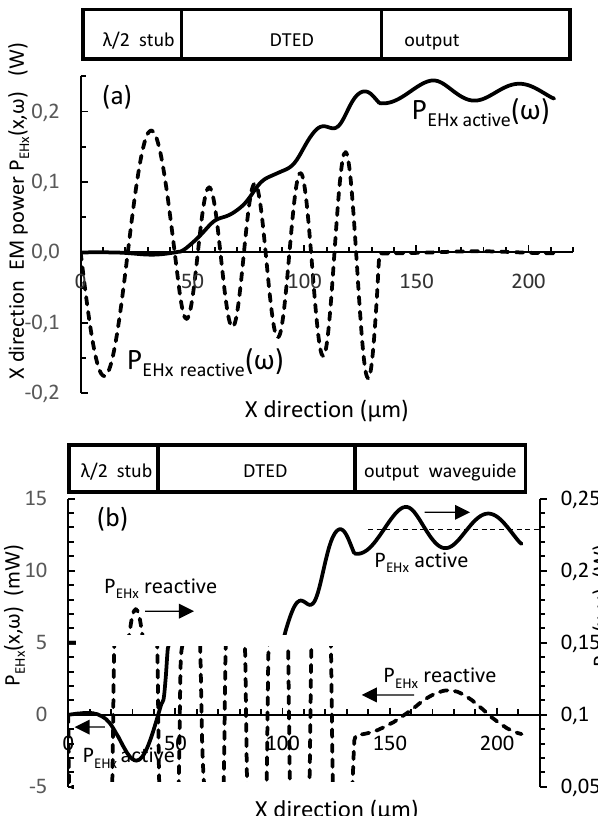
Figure 9: X direction EM power P EHx through S yz area at the fundamental frequency. (a) full scale, (b) zoom